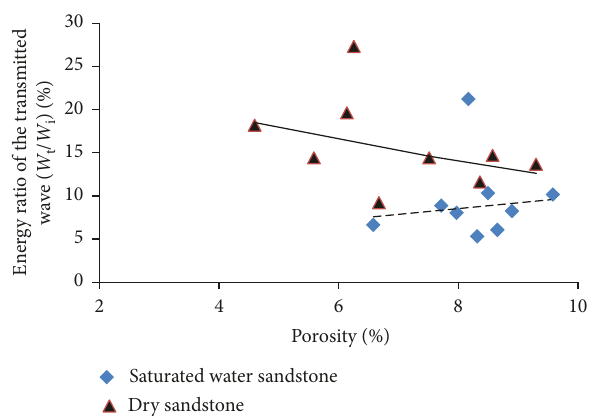
Figure 7: Effect of porosity on transmitted wave energy.